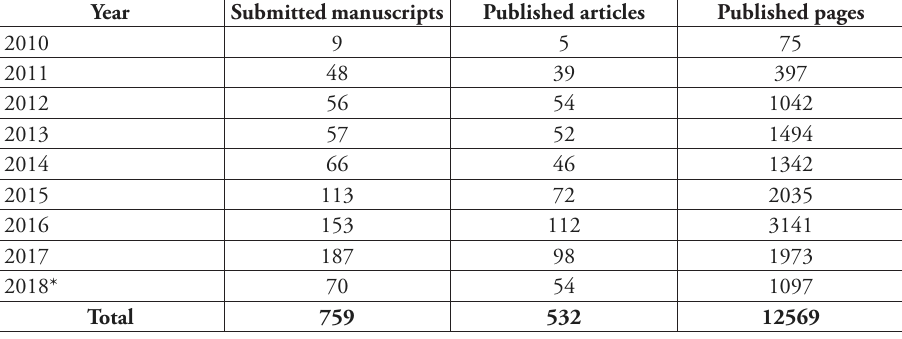
Table 1. Total number of submitted manuscripts, published articles, and printed pages since 2010.